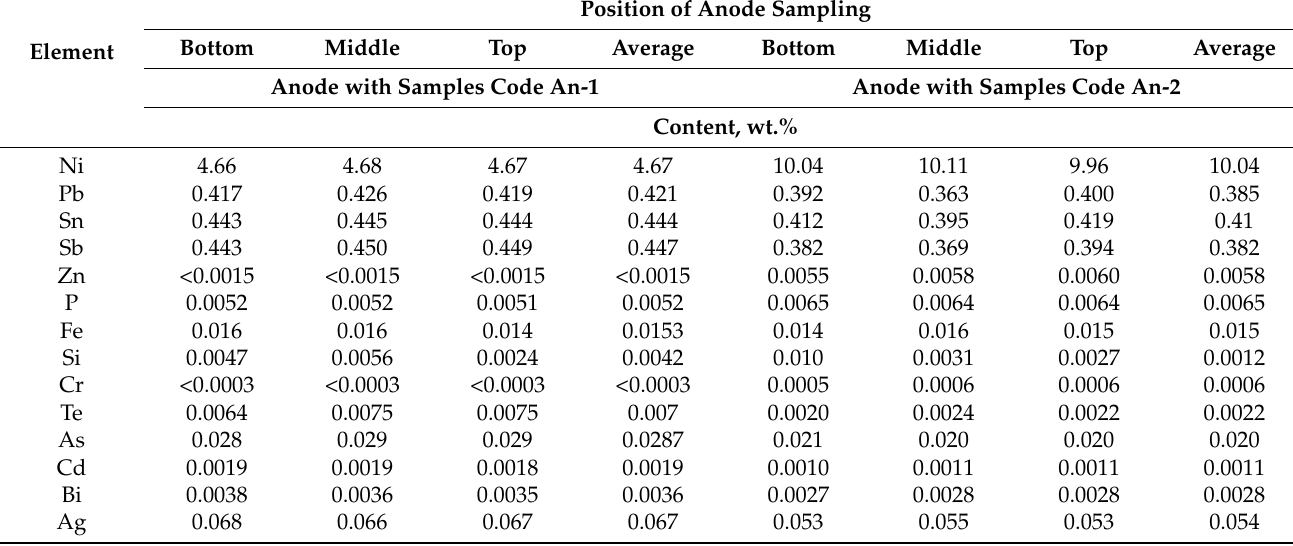
Table 1. Chemical composition of copper anodes with Ni, Pb, Sn, and Sb non-standard chemical content. Position of Anode Sampling Bottom Middle Top Average Bottom Middle Top Average Element Anode with Samples Code An-1 Anode with Samples Code An-2 Content, wt.%